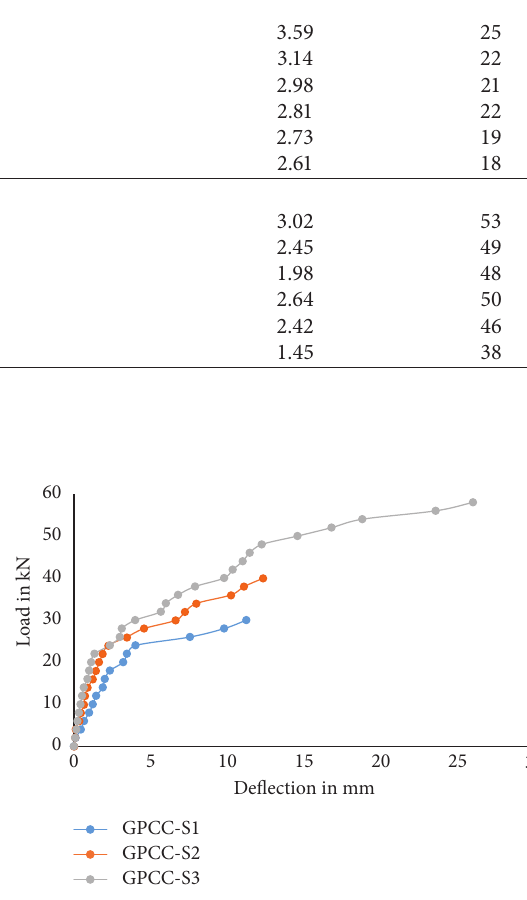
Figure 13: Load-deflection behaviour of GPCC (SRB).